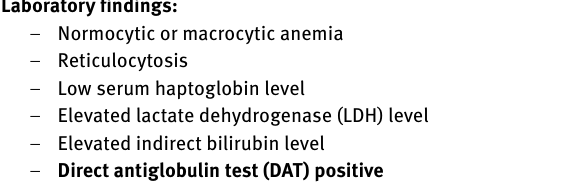
Table 2: Criteria for diagnosis of AIHA